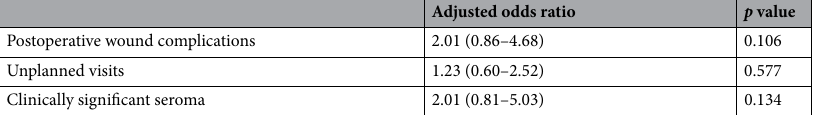
Table 4. Odds ratio adjusted for potential confounders. Corrected for the potential confounders axillary clearance, neoadjuvant chemotherapy, the use of anticoagulants, smoking, CCI, BMI and